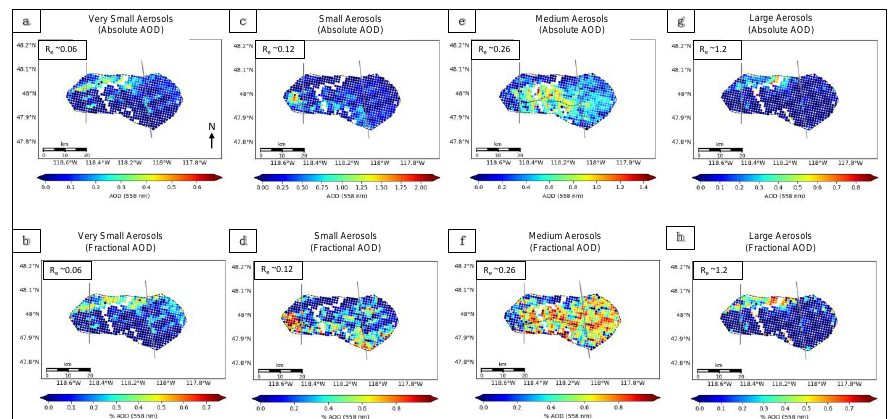
Figure 4. The absolute and fractional AOD (558 nm) of various MISR-RA aerosol components for the Williams Flats Fire on 06 August, 2019, where ( a , b ) are the sum of all spectrally “flat” or BC-like components, ( c , d ) are the sum of all spectrally “steep” or BrC-like components, ( e , f ) are the sum of all non-light-absorbing components, and ( g , h ) are the non-spherical, dust-like components. Fractional plots are given as a fraction of 1. Note: scales differ between panels.